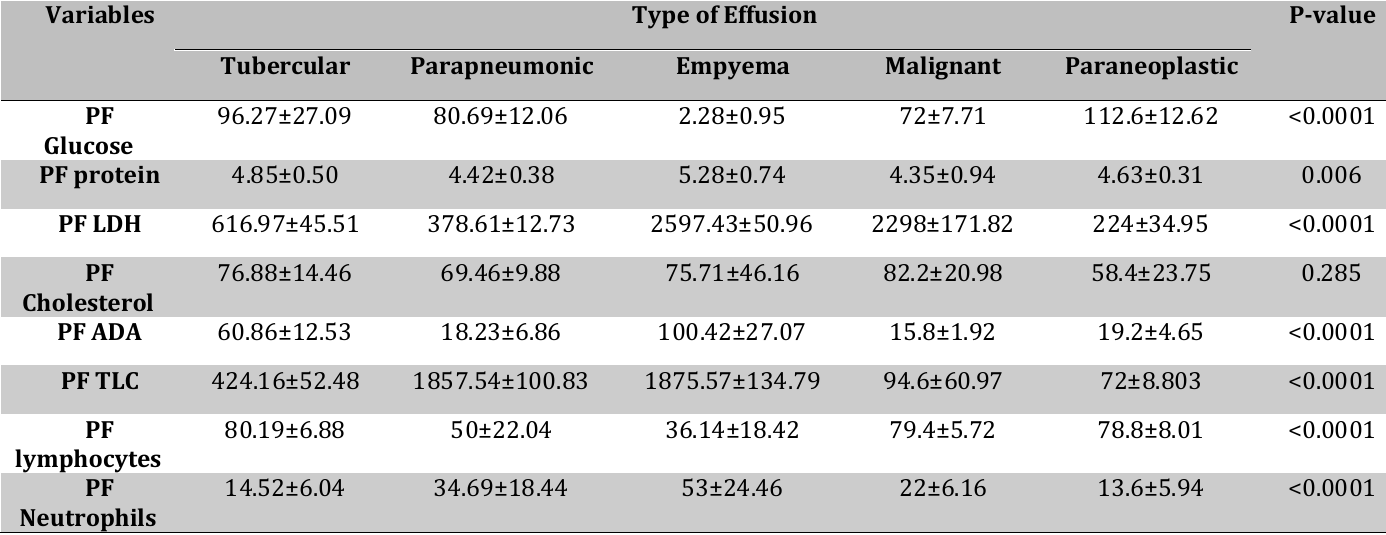
Table 1. Analysis of parameters of pleural fluid in exudative effusionsd.